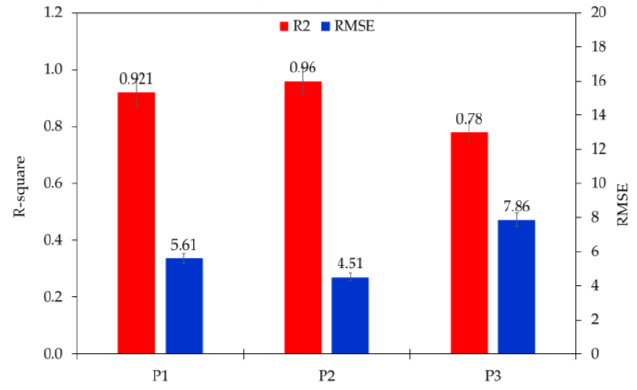
Figure 14. Cross-well prediction using Bi-LSTM.